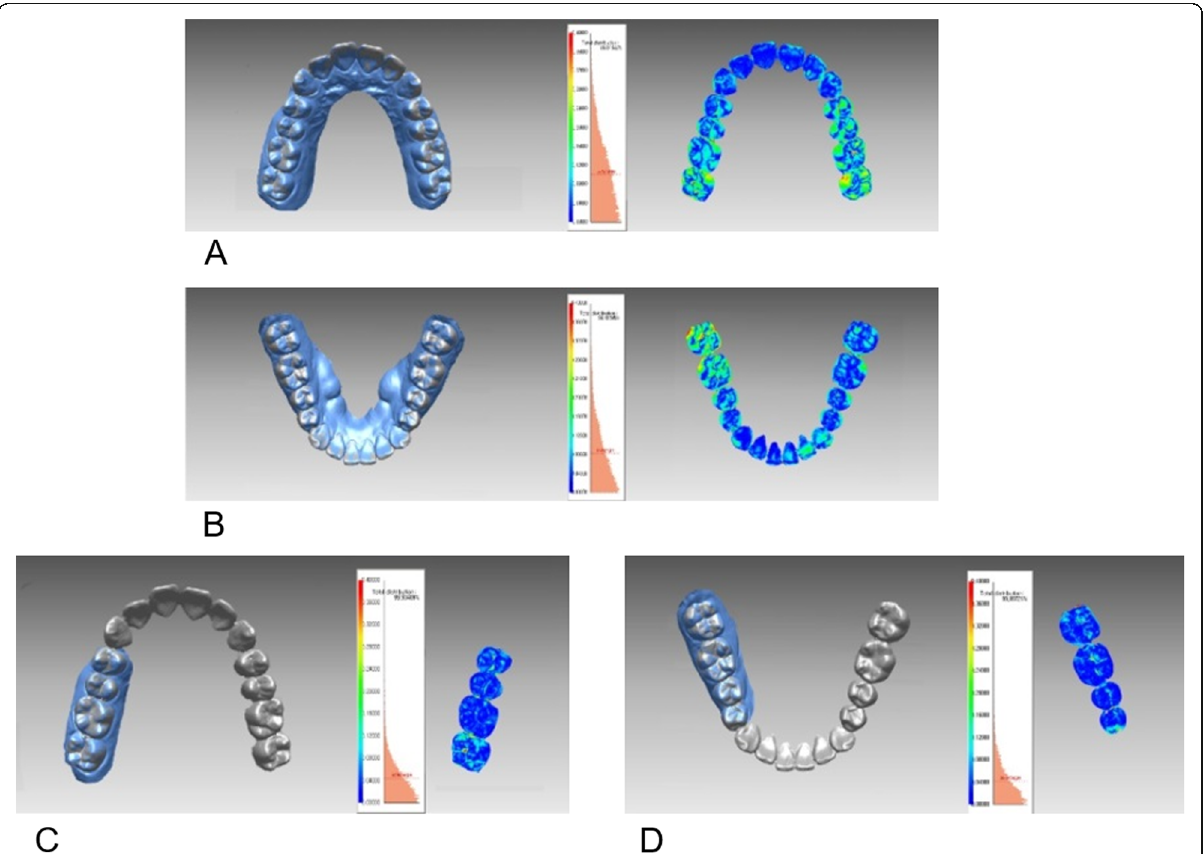
Fig. 2 Three-dimensional superimposition with the laser-scanned image and color-coded visualization charts showing shell/shell deviation in complete-arch scan ( a , b ) and quadrant scan ( c , d ) images. Right posterior scan images were presented as an example of quadrant scan